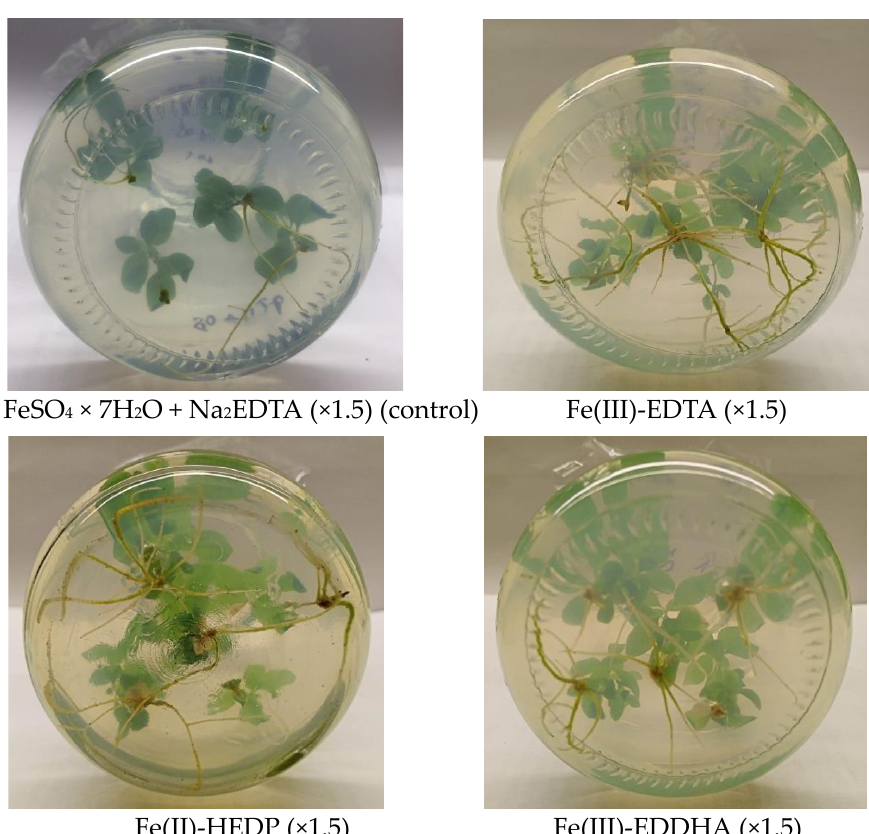
Figure 4. Rooting rate at the end at the stage of rooting microplants of blue honeysuckle “Lulia” ( Lonicera caerulea var. kamtschatica Sevast.) depending on the iron chelate type at an increased concentration (×1.5) in the MS nutrient medium.